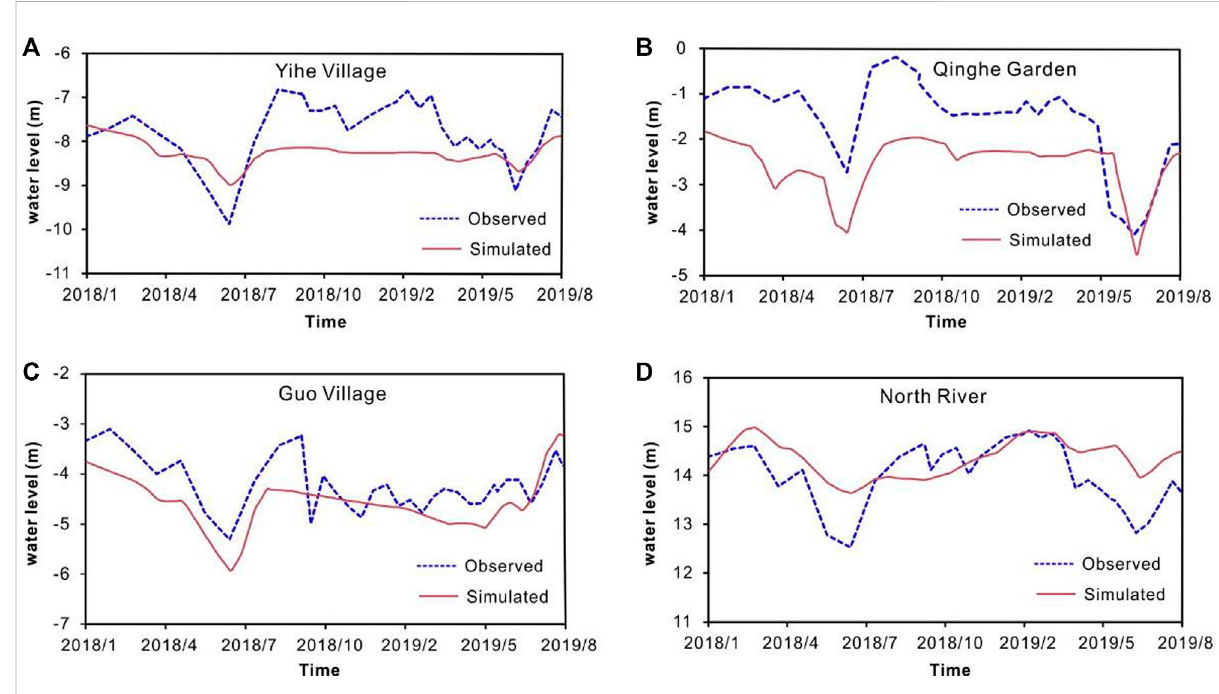
Figure 2. The results demonstrated that the model simulations suitably re fl ected the actual features of the groundwater